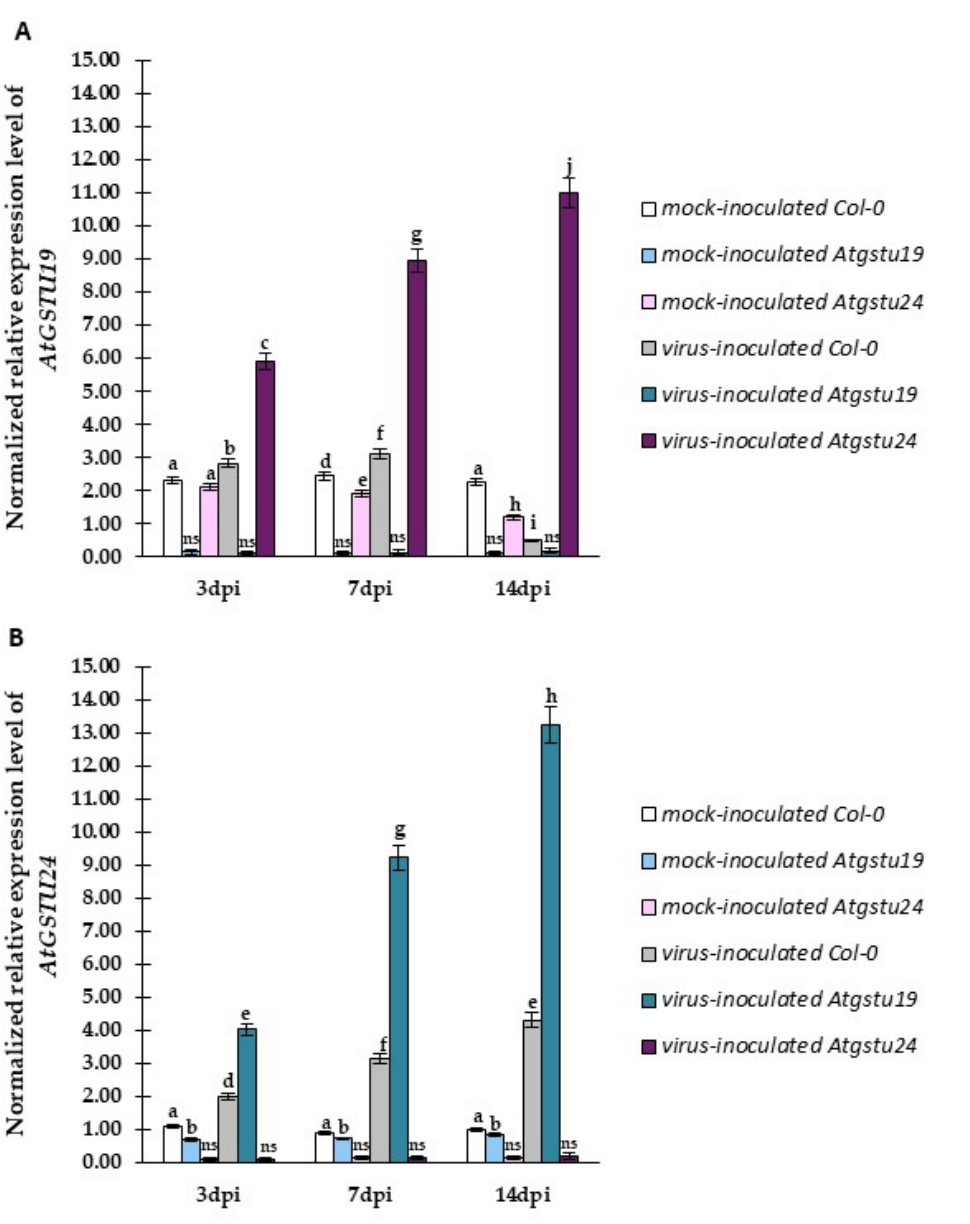
Figure 9. The normalized relative expression levels of AtGSTU19 ( A ) and AtGSTU24 ( B ) calculated based on the mean expression of AtEf1 α and AtF-Box reference genes in mock- and virus-inoculated Col-0, Atgstu19, and Atgstu24 plants between 3 and 14 dpi. The mean values of the normalized expression levels were calculated using ANOVA and Tukey’s HSD test at p < 0.05. Statistically significant values are indicated by letters above the bar. Nonsignificant values are indicated as ns.